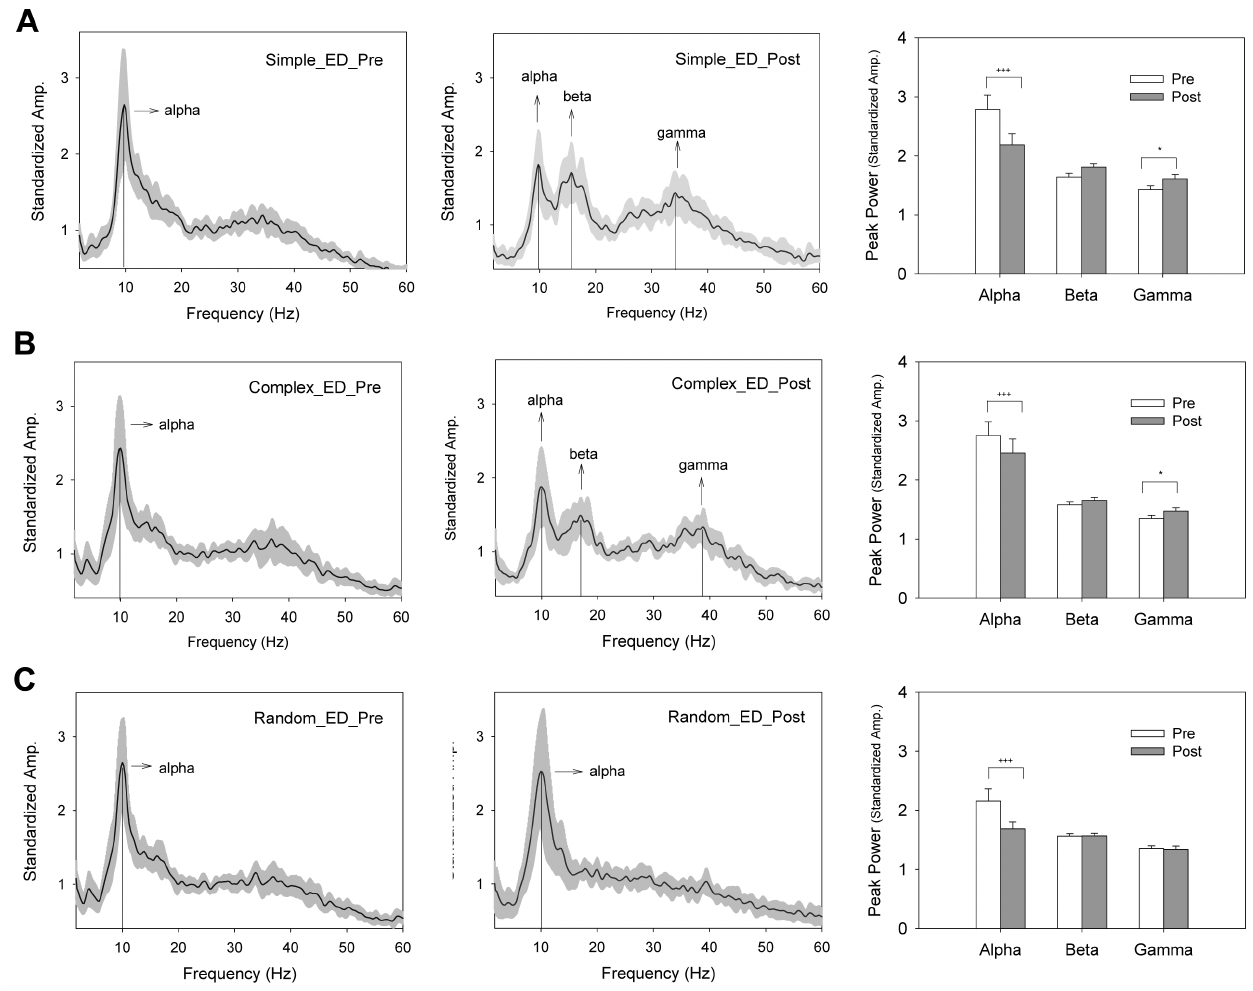
Figure 6. Pooled power spectra of rectified EMG from the ED muscle before and after practice. (A) Simple protocol, (B) Complex protocol, and (C) Random protocol. Visible changes in higher frequency muscular rhythmicity at 13–20 Hz and 35–50 Hz were noted in the simple and complex conditions. The shaded area represents standard deviation of the pooled spectral profile. ( * : post-test . pre-test, p , 0.05; +++ : pre-test . post-test, p , 0.001)(ED: the extensor digitorum).